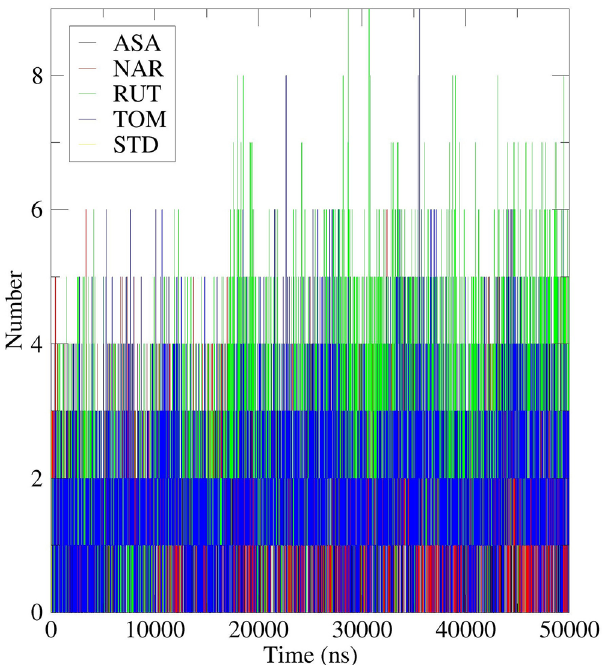
Figure 15. Intermolecular hydrogen bonding study plot for 50 ns MD Simulation of 7AQB-APO (Black), 7AQB-ASA (Red), 7AQB-NAR (Green), 7AQB-RUT (Blue) 7AQB-TOM (Yellow) and 7AQB-STD